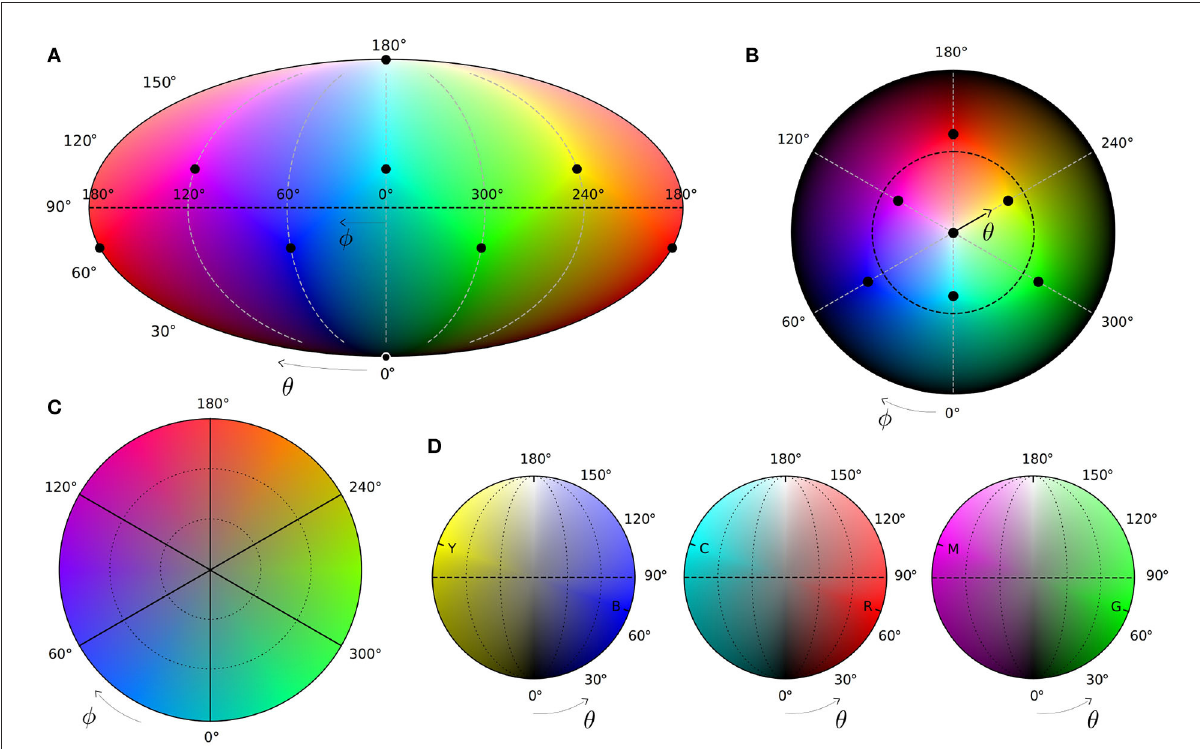
FIGURE6 Color map of the qubit state space (Equation 17). Top: pure colors on the surface of the Bloch sphere in Mollweide (A) and polar (B) projections. Dots locate eight main colors (Equation 11), 13, and 15) in the vertices of the color cube (Figure 5), dashed lines show the equatorial plane. Bottom: mixed colors inside the Bloch sphere in equatorial section (C) and three vertical sections (D) going through solid lines in panel (C) and opposite pairs of the main chromatic colors. Dotted lines show elliptical surfaces of constant saturation 1 / 3 and 2 / 3. Produced by Matplotlib 3.3.4 (Hunter,